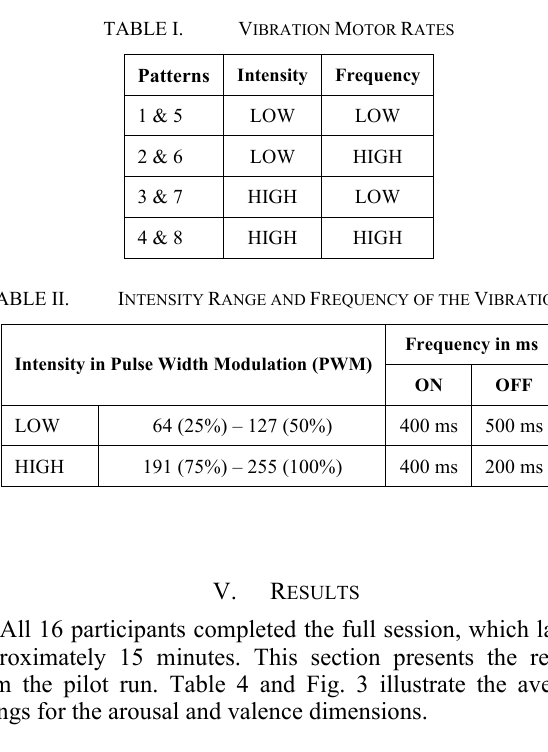
Figure 2. Modified version of SAM [2] used in this study, with top panel representing valence, and bottom panel representing arousal; and with a coding scale (not shown to participant) from left to right for each panel: -2, -1, 0, +1, -1